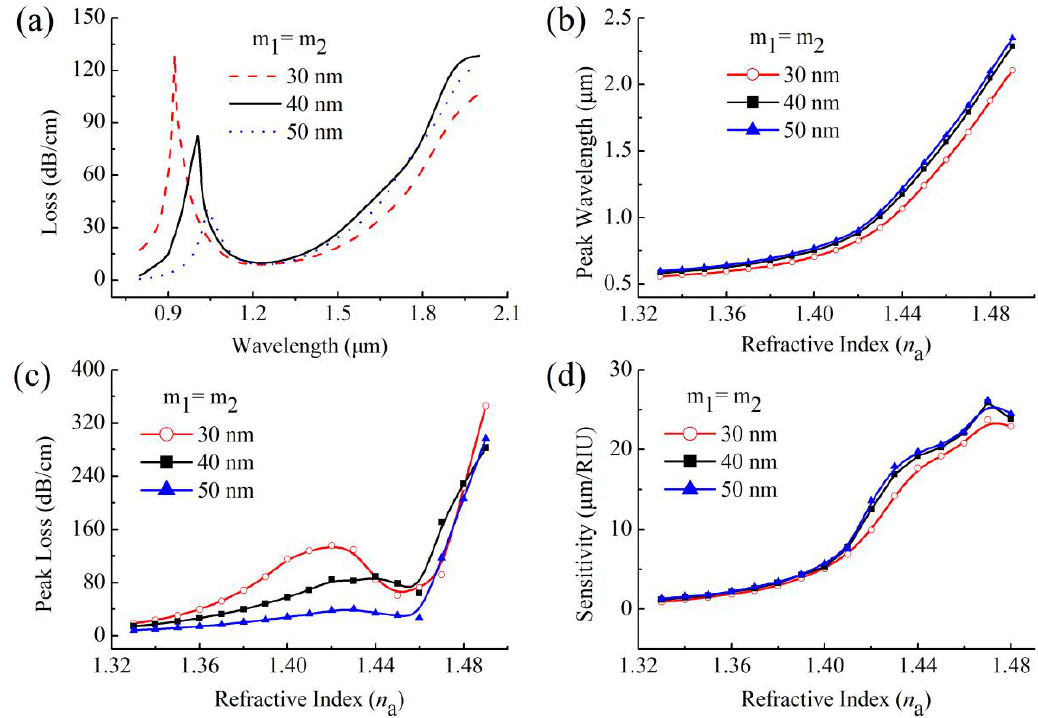
Figure 3. ( a ) Loss spectra of the SPR sensor at n a = 1.43 when the thickness of gold film ( m 1 = m 2 ) is 30 nm,40 nm, and 50 nm; ( b ) peak wavelengths, ( c ) peak loss and ( d ) sensitivities of the SPR sensor at various n a when the thickness of gold film ( m 1 = m 2 ) is 30 nm, 40 nm, and 50 nm.